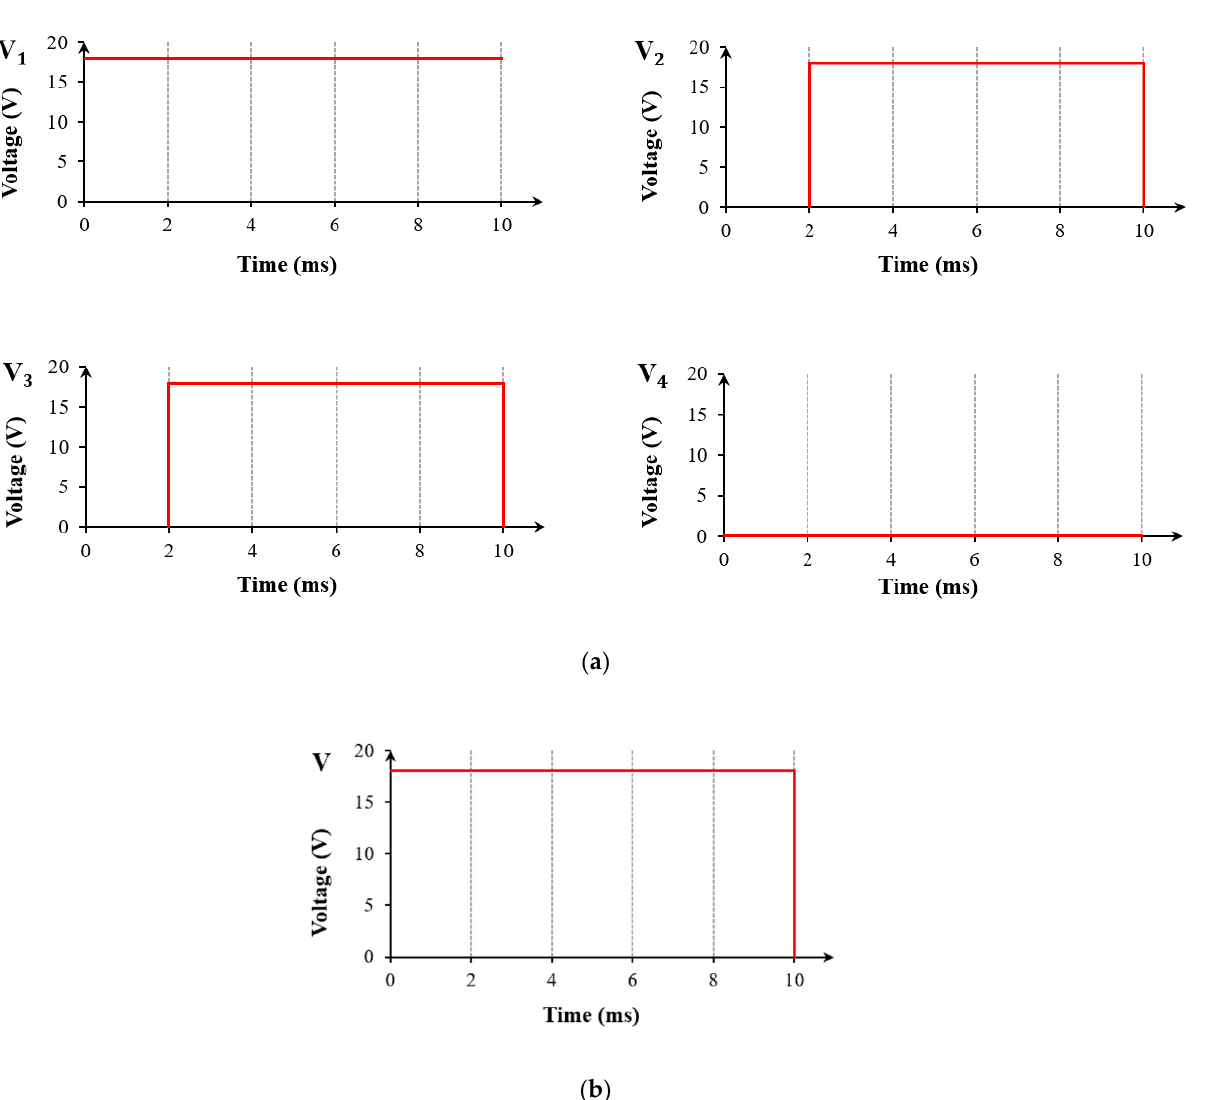
Figure 5. Sequence diagram of applying voltage to a multi-electrode pixel and a single-electrode pixel. ( a ) Sequence diagram of applying voltage to electrodes of the multi-electrode pixel. V1, V2, V3, and V4 represent the voltage applied to sub-electrodes 1, 2, 3, and 4, respectively. The voltage was first applied to sub-electrode 1, then simultaneously applied to its two adjacent sub electrodes 2 and 4, the finally removed. ( b ) Sequence diagram of applying voltage to electrode of the single-electrode pixel. The voltage was applied to the whole pixel and then removed.